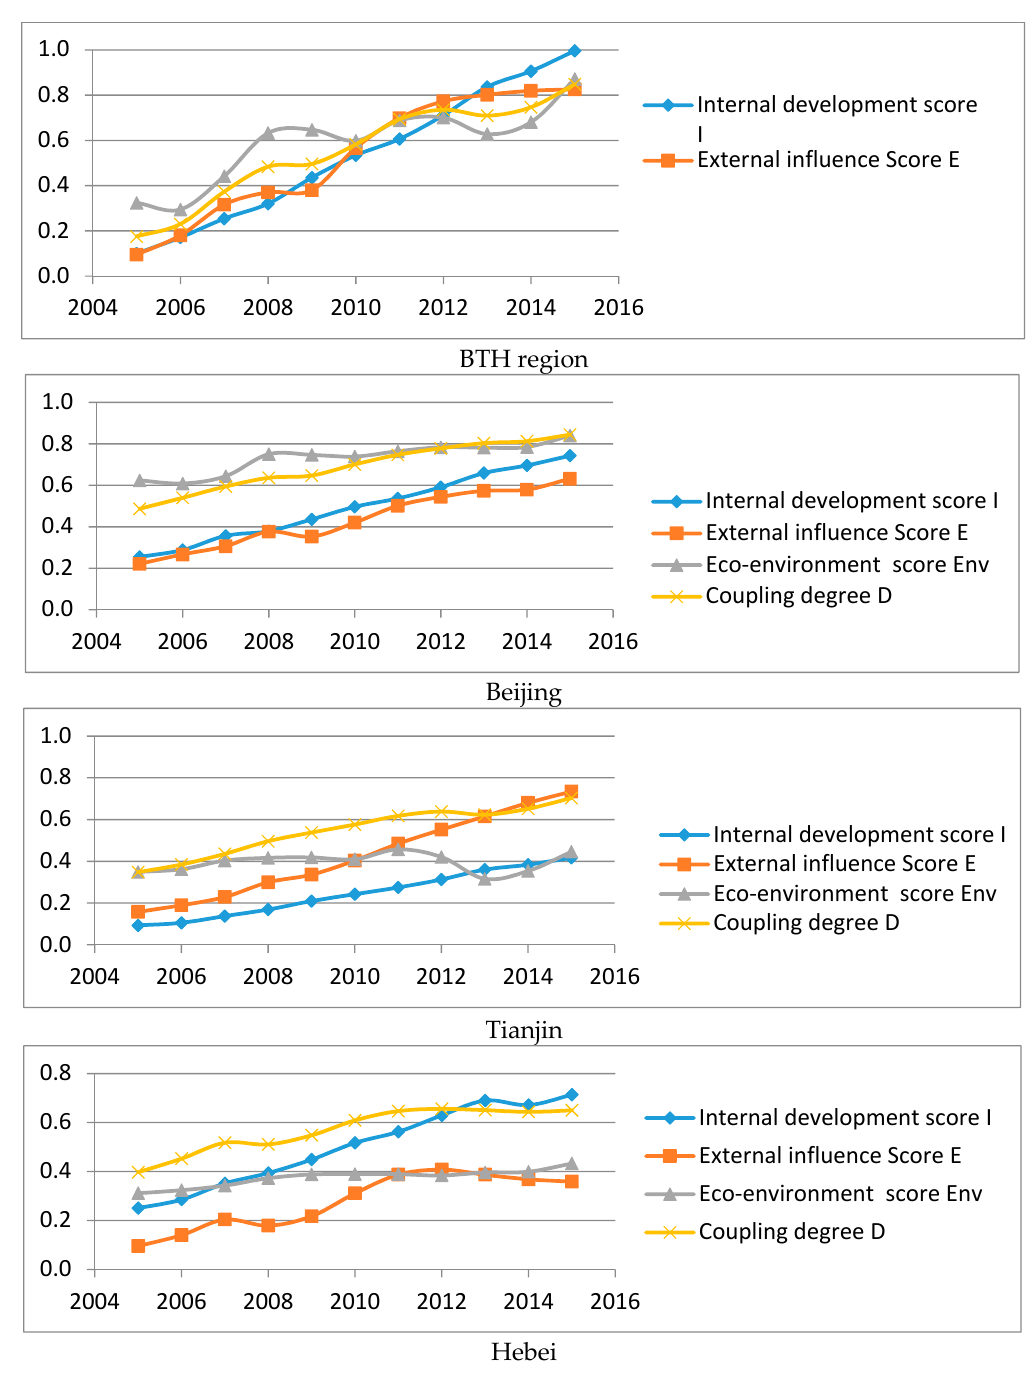
Figure 7. Coupling coordination degree of internal development, external influence, and eco- Figure environment in BTH from 2005–2015. Source: Drawn by the authors.